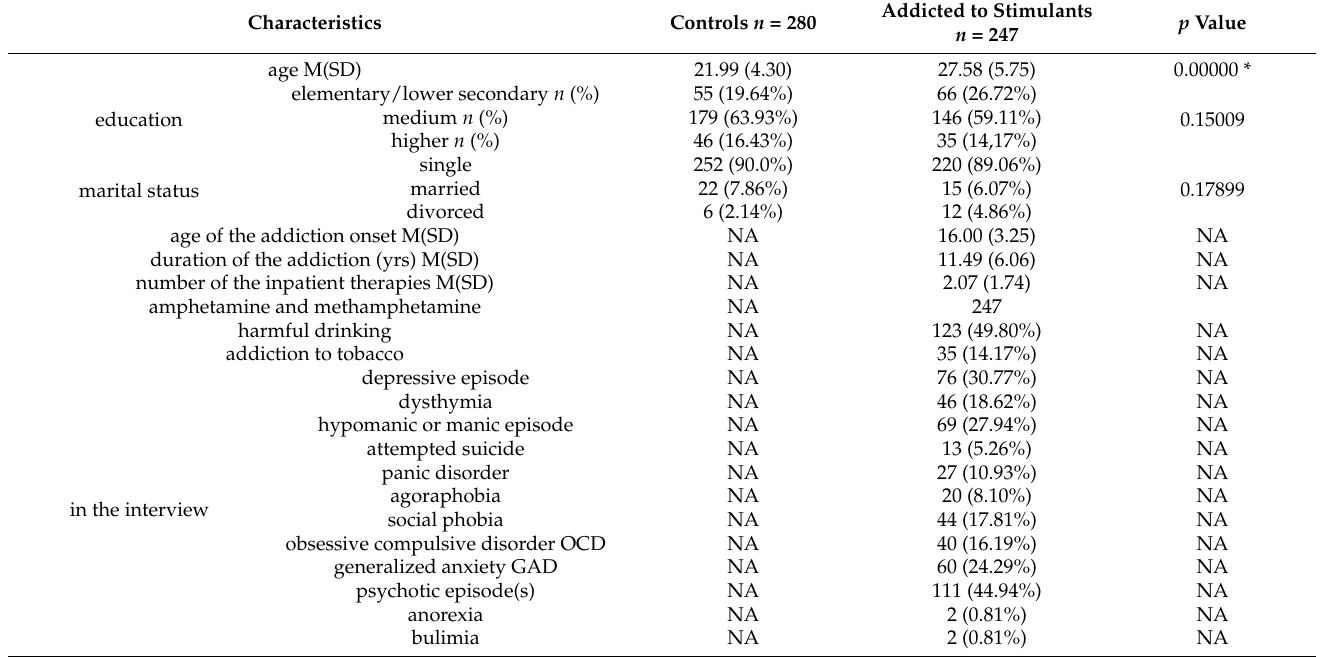
Table 1. The comparison of the basic sociodemographic variables and coexisting psychiatric distur- bances in patients addicted to stimulants and the control